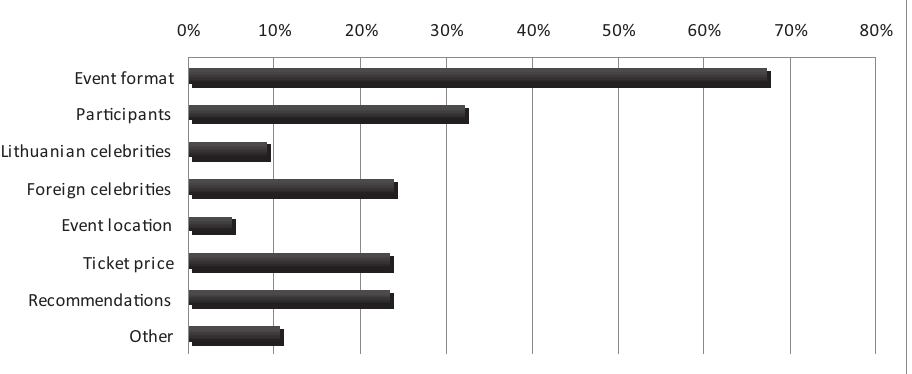
Fig. 3. Key factors of choosing the